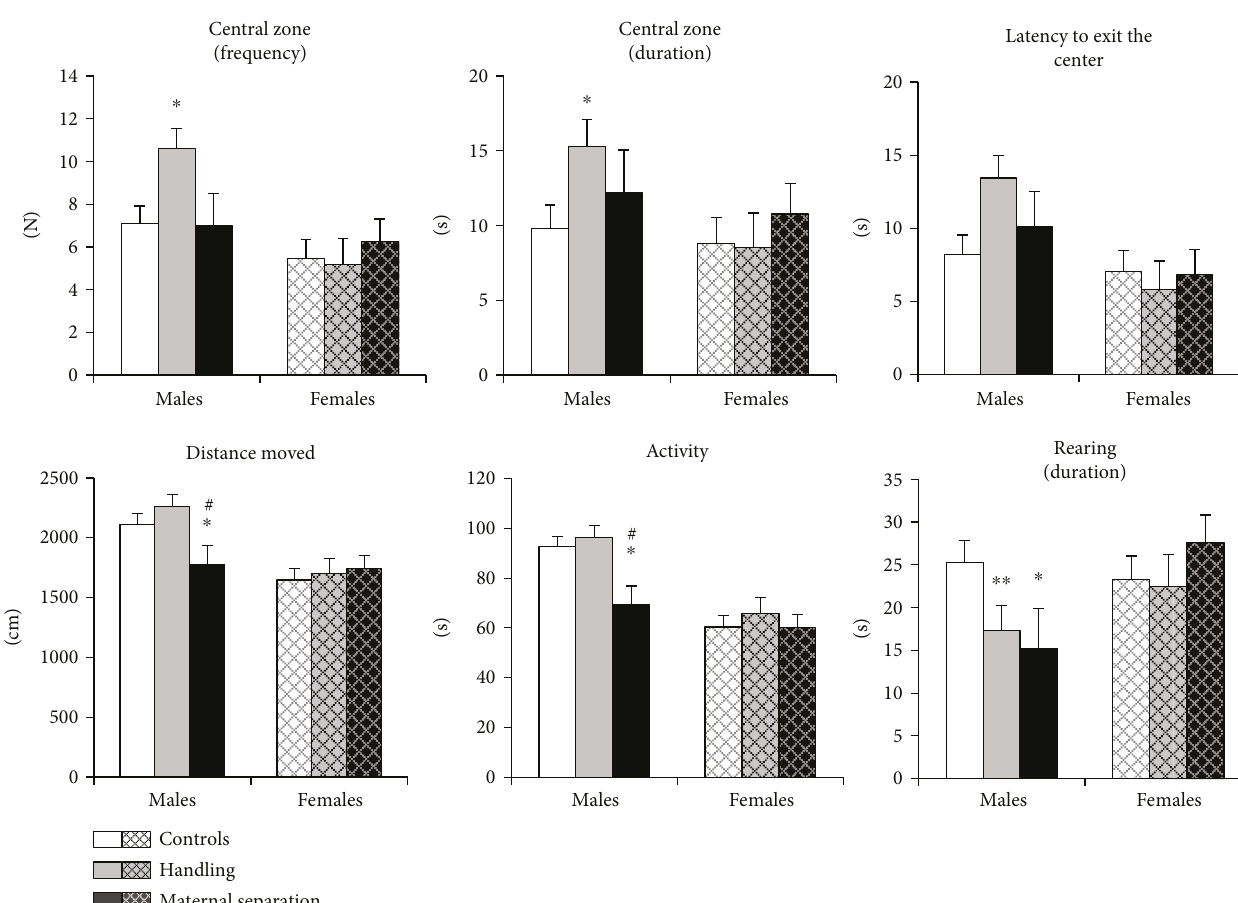
Figure 4: E ff ects of early-life stress on the behavior of adult mice in the open- fi eld test. Male mice showed decreased locomotor and exploratory activities of MS males and decreased anxiety-like behavior in HD males. Females did not show the behavioral changes in the test. Data present as mean ± standard error of the mean (SEM). White box: controls (males n = 11 , females n = 11 ); grey box: HD (males n = 10 , females n = 6 ), black box: MS (males n = 6 , females n = 8 ); open columns: males; cross-hatched columns: females. ∗ p < 0 05 , ∗∗ p < 0 01 compared to controls; # p < 0 05 compared to